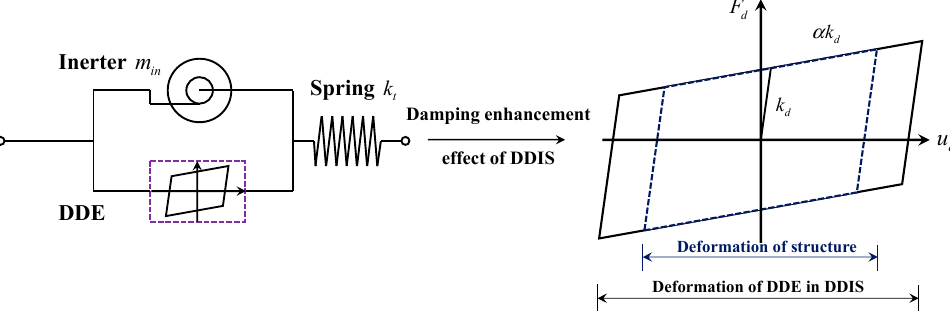
Figure 3. Schematic of the proposed displacement-dependent damping inerter system (DDIS) and its damping-enhancement effect.